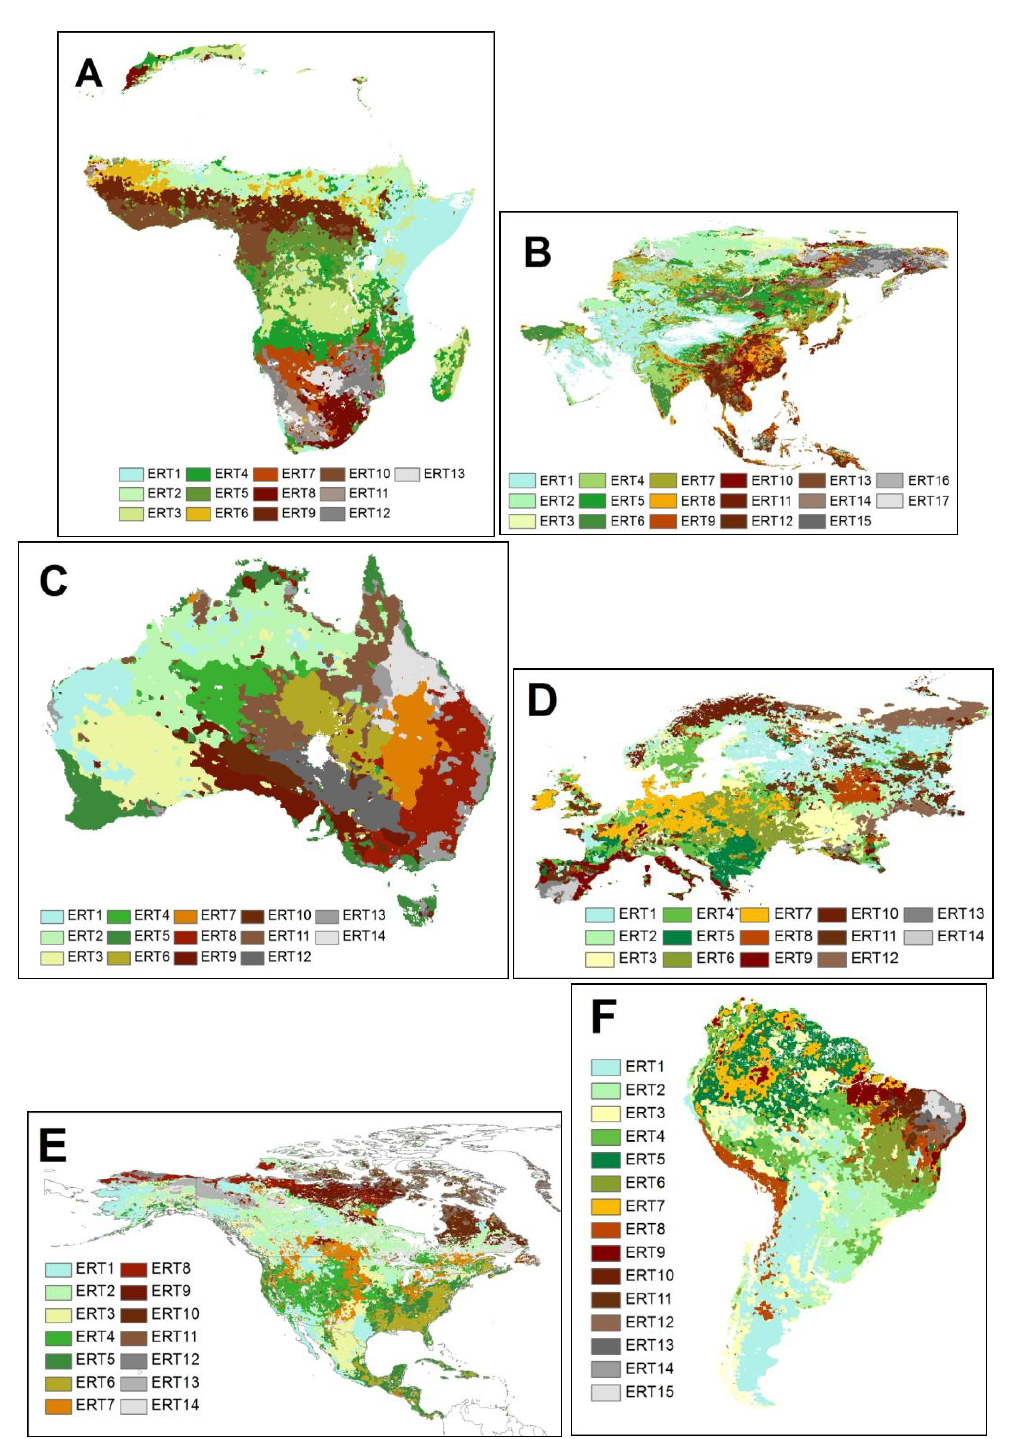
Figure 1. Ecosystem Response Types (ERTs) derived by spatio-temporal analysis of co-varying SPEI12 and FPAR3g anomalies for ( A ) Africa, ( B ) Asia, ( C ) Australia, ( D ) Europe, ( E ) North America and ( F ) South